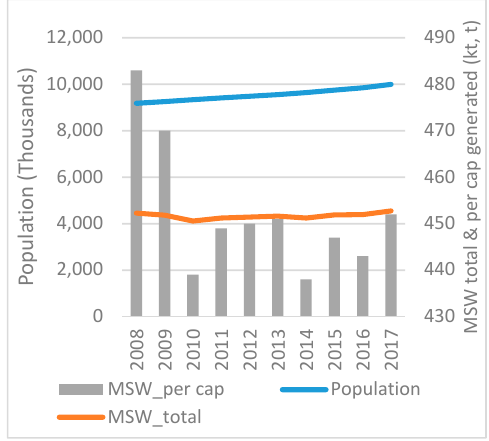
Figure 53. Population and MSW production in Sweden 2008–2017 (EUROSTAT 2019a, 2019c). Soc. Sci. 2019 , 8 , x FOR PEER REVIEW